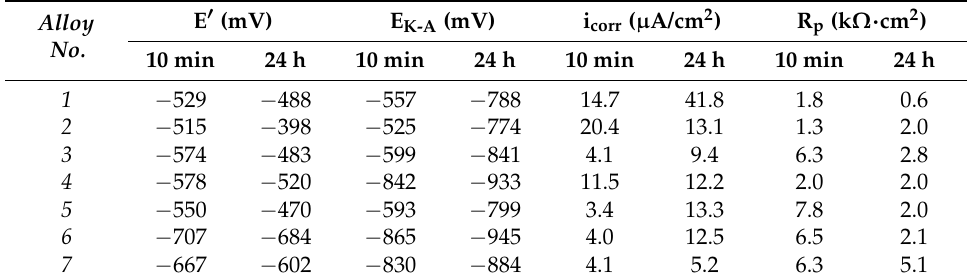
Table 5. Electrochemical indices characterising corrosion processes.